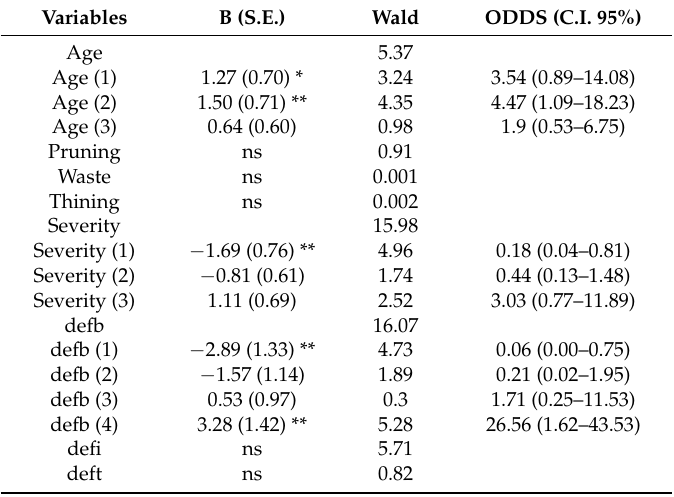
Figure 3. Relationship among fungal infection severity, symptoms, and tree characteristics in the surveyed plantations. Variety and dimensions of dichotomized presence absence of needle pathogenic species, healthy vs. unhealthy, visualized with multiple correspondence analysis and the